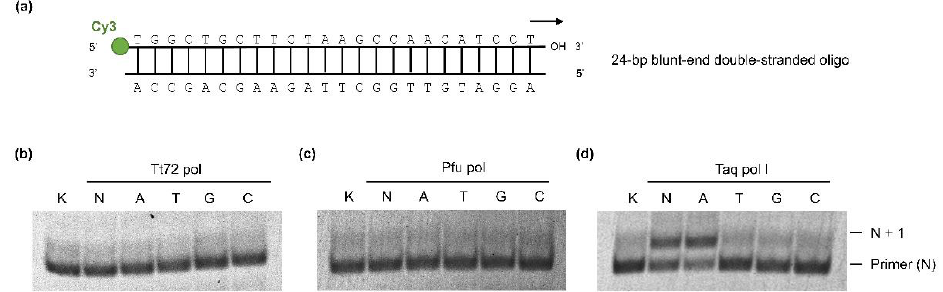
Figure 6. Determination of terminal transferase activity of Tt72 pol. The 24-bp blunt-end double- stranded oligo with the fluorescent label was used as a template ( a ). The products of extension reactions are shown in ( b ) Tt72 pol, ( c ) Pfu pol (negative control), and ( d ) Taq pol I (positive control). The strand extension reaction for each enzyme was carried out for 20 min with either a mixture of all dNTPs or only one: lane A, dATP; T, dTTP; G, dGTP; and C, dCTP, respectively.